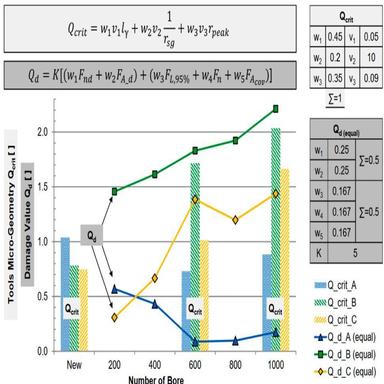
Comparison of the tool wear parameter Qcrit from with the bore hole quality parameter Qd for a sequence of holes made with one and the same tool from.